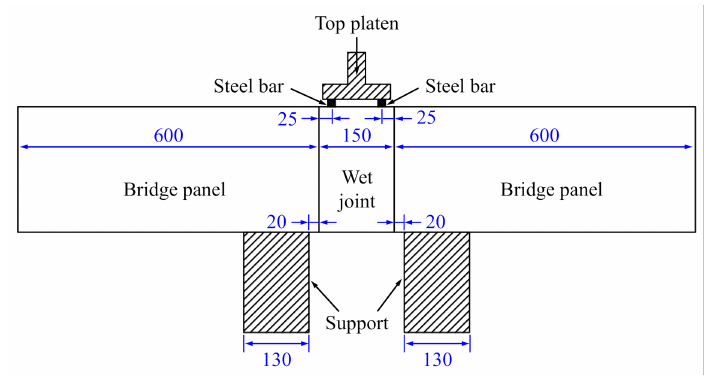
Figure 4. Schematic diagram of the test setup (unit: mm). Figure 5a,b present the final failure modes of S-CWJ and S-SWJ, respectively. Cracks